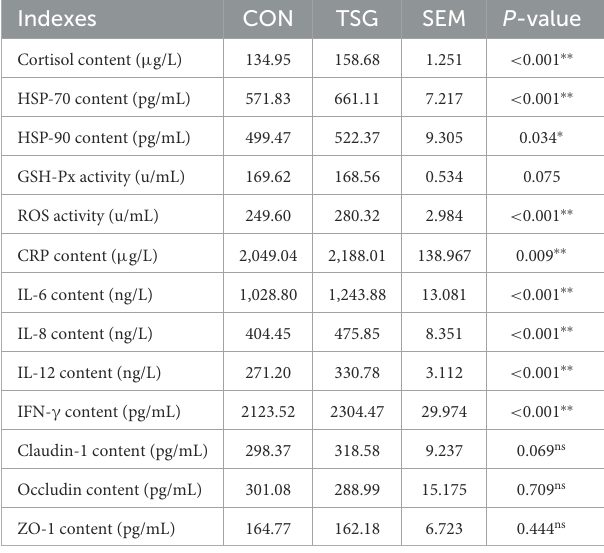
TABLE 2 Effect of transportation on physiological and biochemical indexes of jejunum a